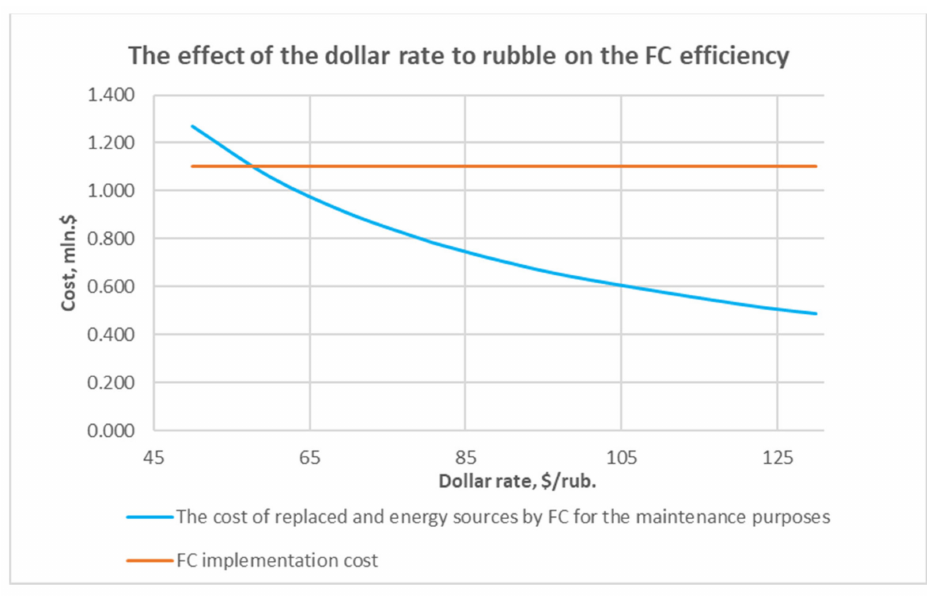
Figure 6. The effect of the dollar rate to ruble on the FC efficiency in the case of covering the economic needs of the station by